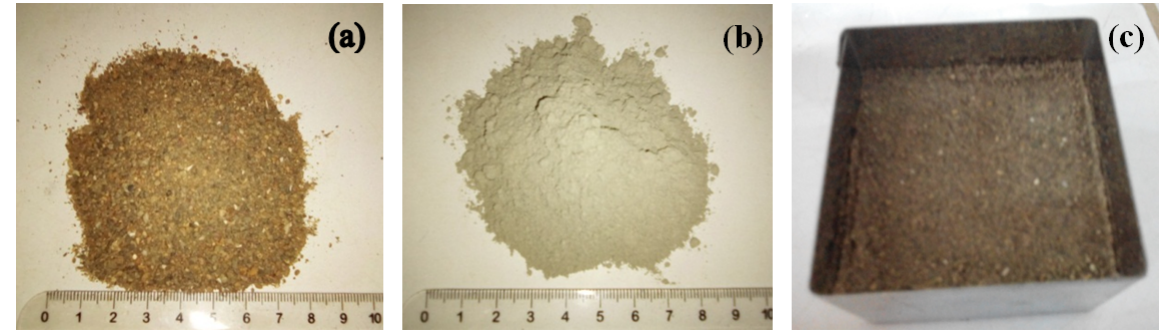
Figure 3: Materials used in this study: (a) Sand, (b) Cement, (c) Sample